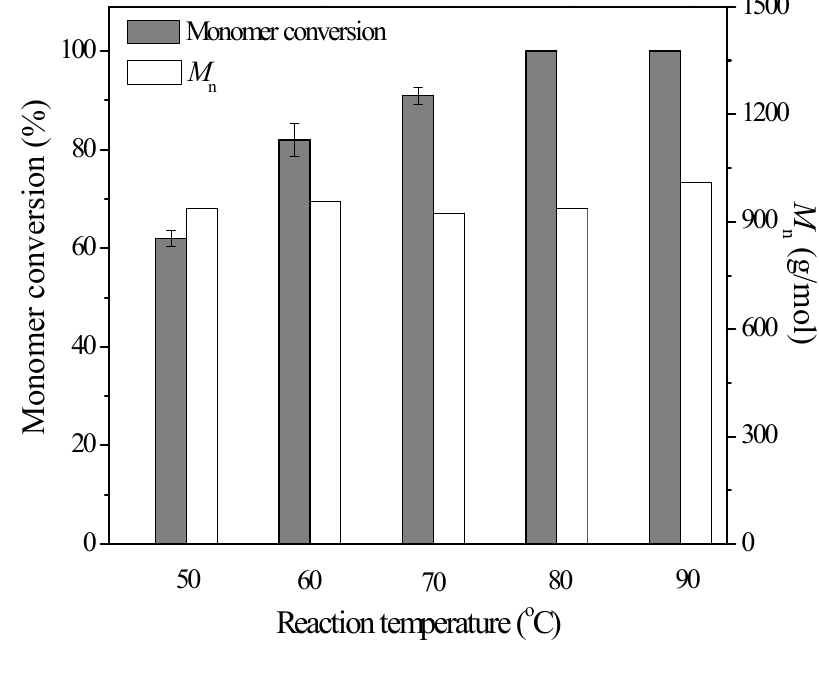
Figure 3. Immobilized enzyme-catalyzed ring-opening polymerization of ε -caprolactone at different temperatures. The reactions were carried out using 60 mg immobilized enzymes, 200 μ L ε -caprolactone and 600 μ L toluene for 72